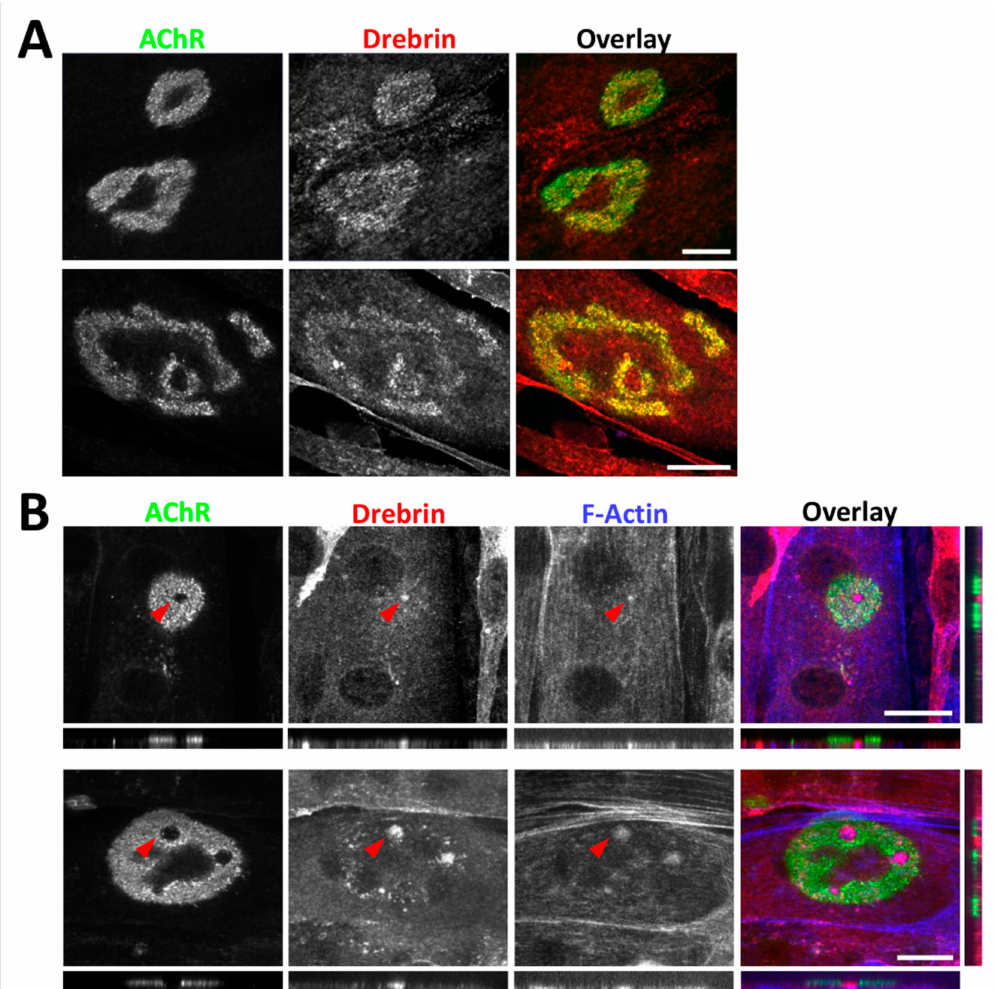
Figure 3. Drebrin localizes to the postsynaptic machinery in vitro. ( A ) Colocalization of drebrin (red) with BTX-labeled AChR clusters (green) in C2C12 cultured myotubes. ( B ) Colocalization of drebrin (red) with F-actin (blue) of synaptic podosomes in the perforations of simple (upper panel) and complex (bottom panel) AChR clusters (green). Red arrows indicate synaptic podosomes. The localization at synaptic podosomes was confirmed with two anti-drebrin antibodies: upper panel—10260-1-AP, Proteintech; lower panel—25770-1-AP, Proteintech. Bottom and right small panels show optical cross sections of the perforation area (arrow) with visible enrichment of drebrin. Scale bars—20 µ